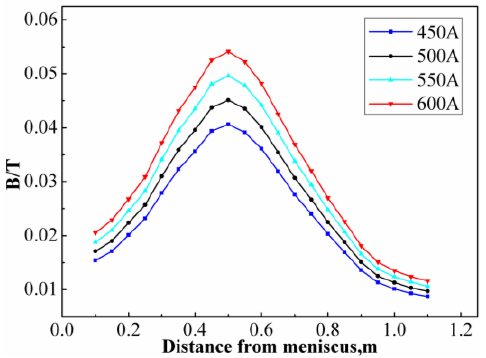
Figure 1. Measured distribution of electromagnetic intensity in the mold under different current intensity.